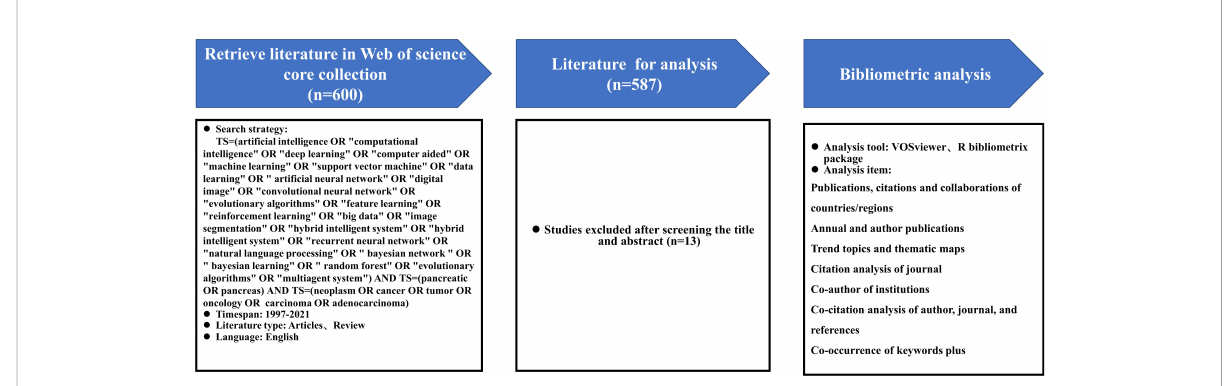
FIGURE 1 Procedures of bibliometric analysis: retrieval strategy, bibliometric analysis tools and